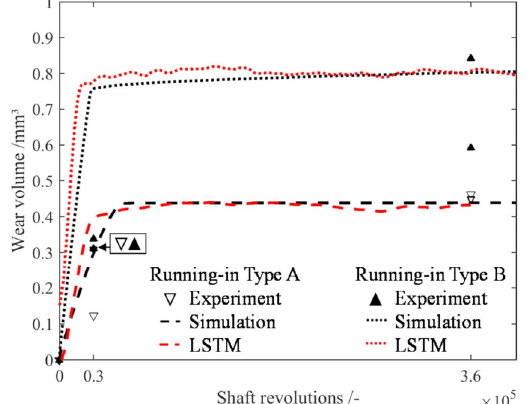
Fig. 33 Comparisons of wear volume vs shaft revolutions between experiment, physical simulation, and the data-driven ANN (LSTM) for two types of running-in [431]. Reproduced with permission from Ref. [431], © Elsevier B.V.,